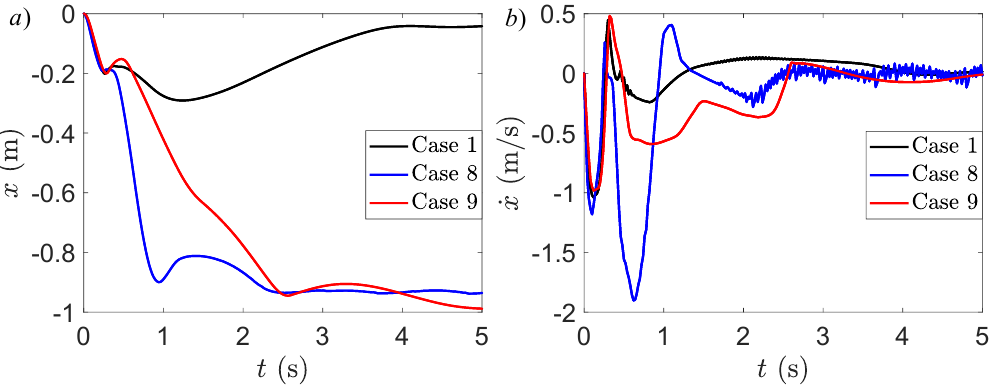
Figure 8. Cart position and velocity for Cases 1, 8, and 9. ( a ) Cart position x during the swing-up task. ( b ) Cart velocity ˙ x during the swing-up task.